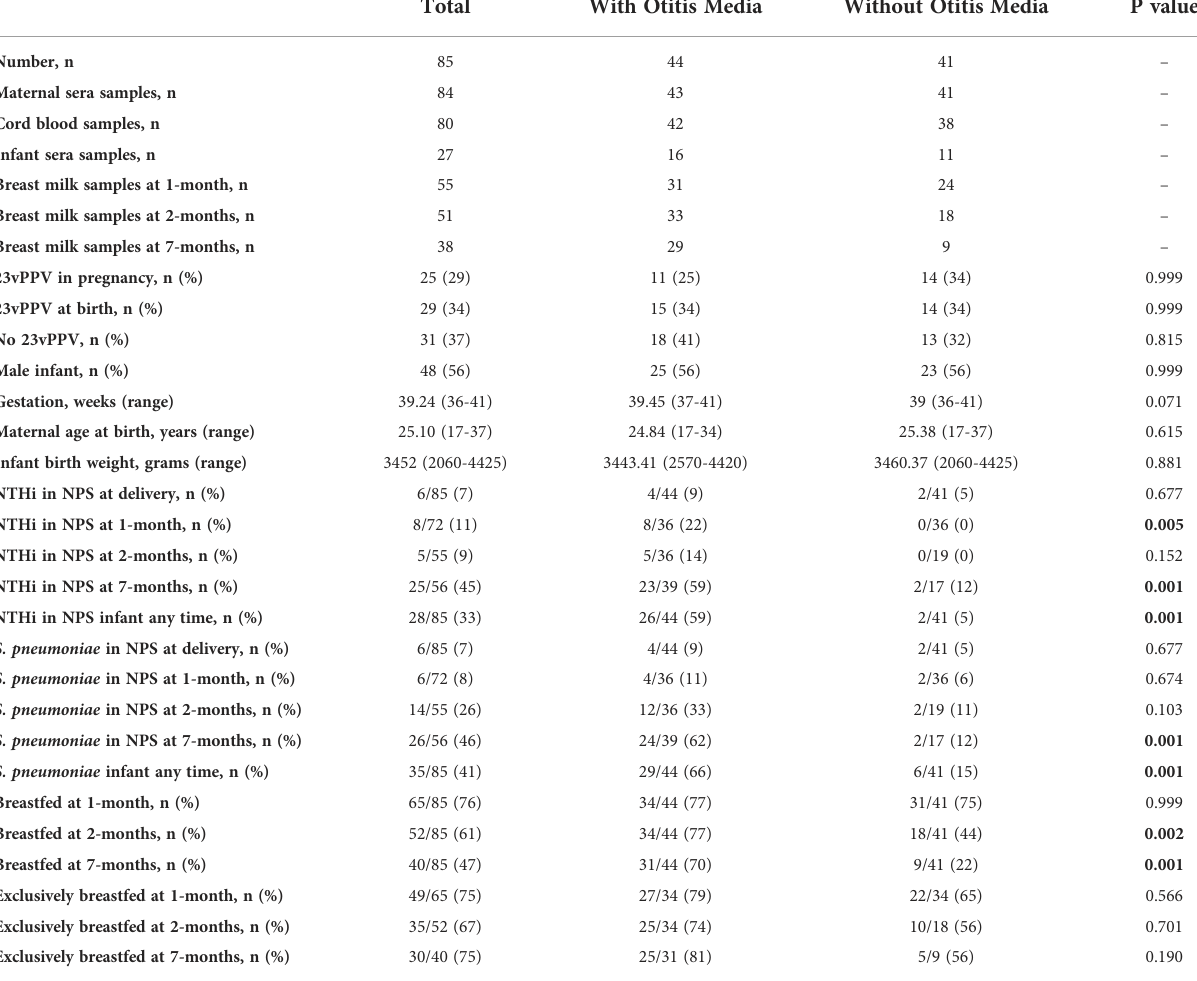
TABLE 1 Participant characteristics as a whole and by infant OM in the fi rst